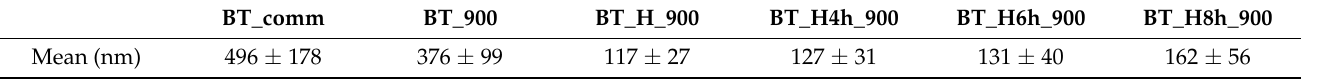
Table 2. Results of the particle size analysis from SEM micrographs.